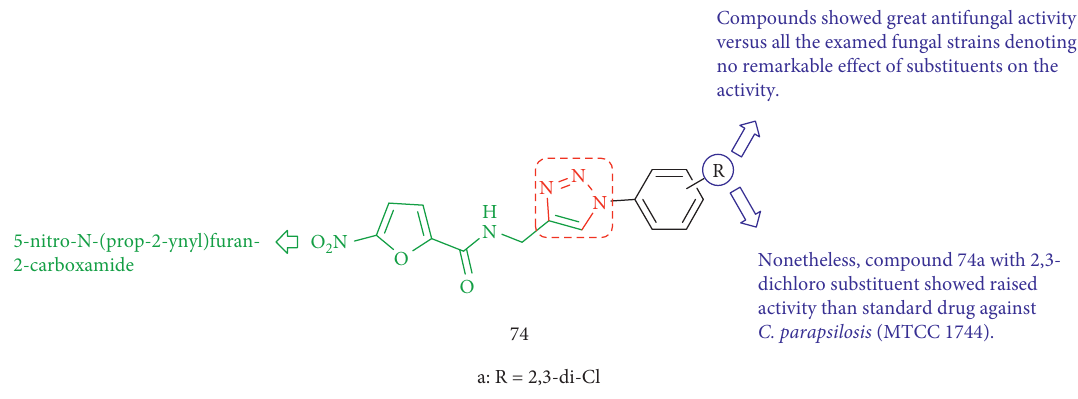
Figure 27: Chemical structure of 5-nitrofuran-triazole